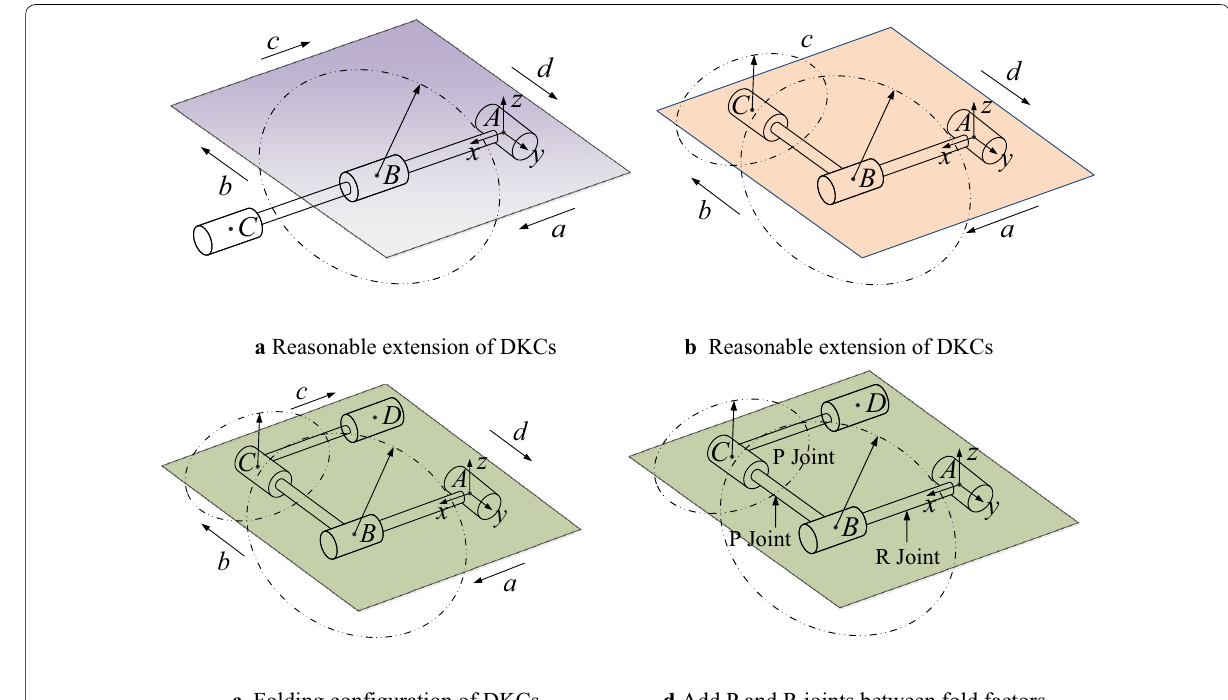
Figure 7 Configuration of the